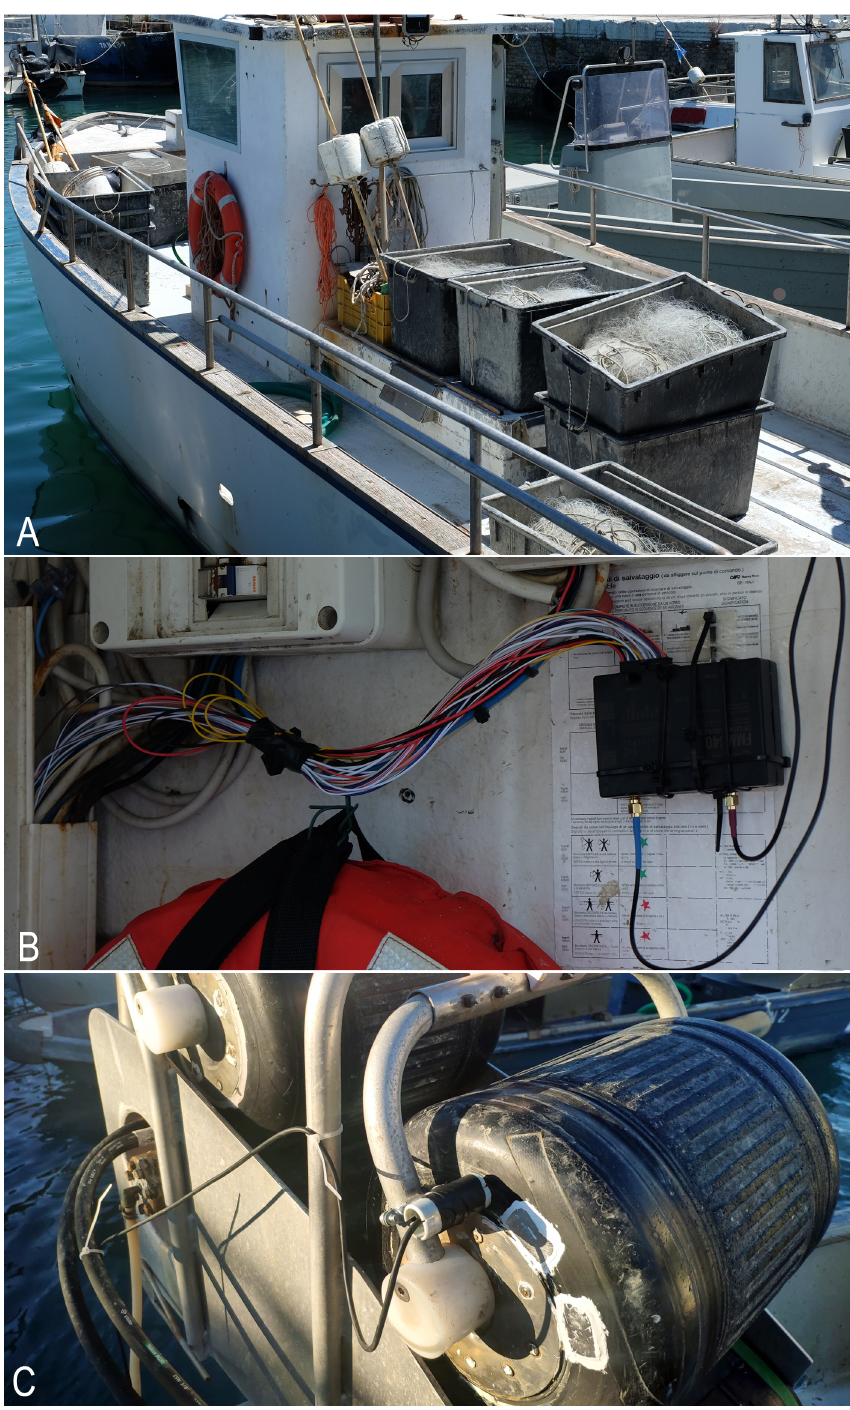
Figure 2. The small-scale fishing vessel ( A ) on board of which the Teltonika FMM640 was installed ( B ) and the proximity inductive sensor attached to the hauler ( C